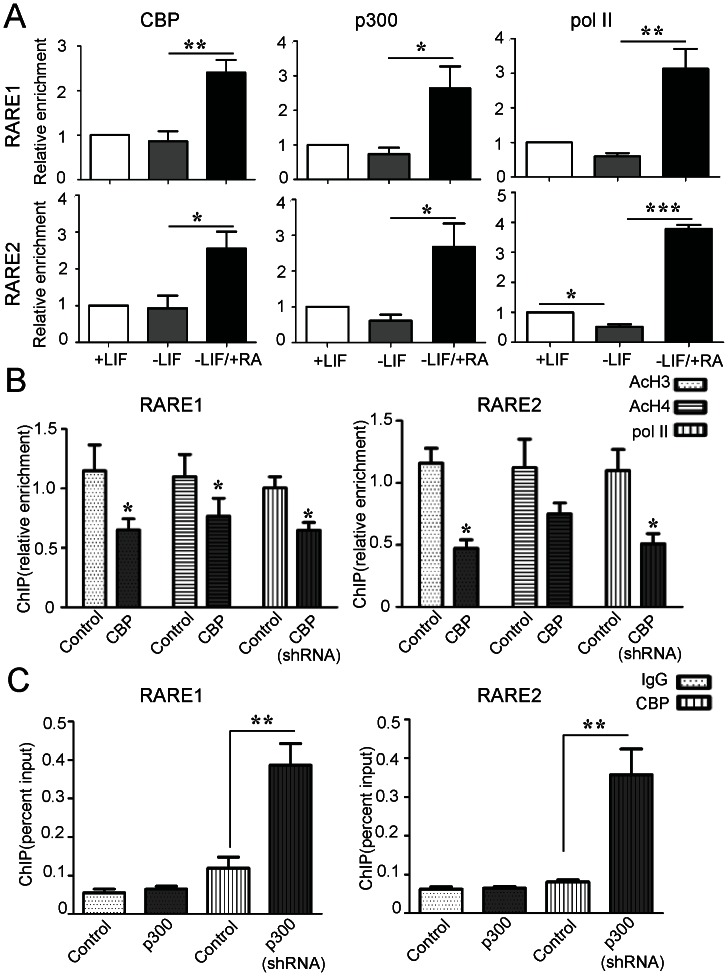
RA increases CBP occupancy at the Stra8 promoter with concomitant increase in histone acetylation and RNA polymerase II recruitment.(A) ChIP analysis of p300, CBP and Pol II (RNA polymerase II) occupancy of the Stra8 promoter in ESCs treated with +LIF, −LIF or −LIF/+RA for 2 h. Data are means ± SEM (n = 3). P<0.05(*), P<0.01(**) and P<0.001(***) vs. −LIF ESCs (One-way ANOVA with Turkey-Kramer post hoc test). (B) ChIP analysis was performed in control and CBP shRNA-infected ESCs treated with RA for 24 h. P<0.05(*) vs. control shRNA cultures (Student’s t-test). Data are means ± SEM (n = 3). (C) ChIP analysis of CBP occupancy of the Stra8 promoter in control and p300 shRNA-infected ESCs following treatment with −LIF/+RA for 1 h. Data are means ± SEM (n = 3). P<0.05(*) vs. control shRNA-infected ESCs using the CBP antibody (Student’s t-test).